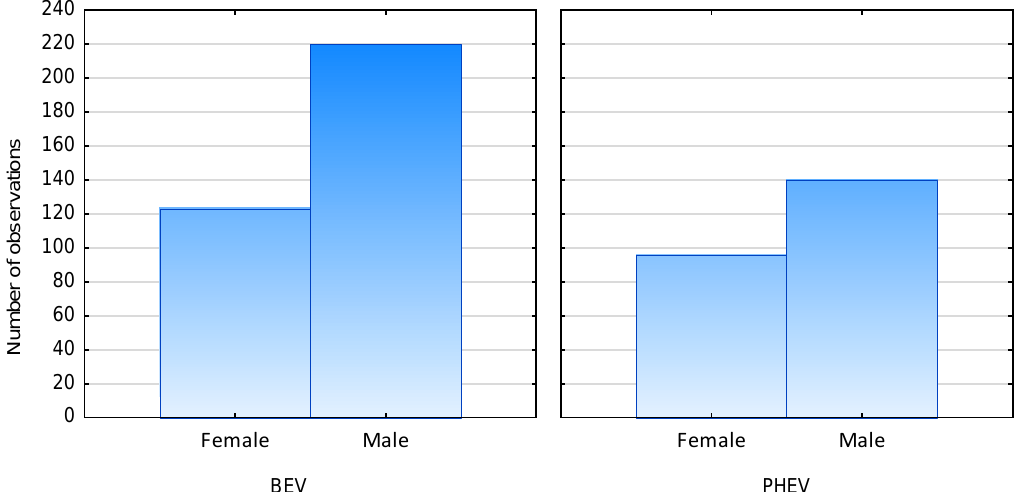
Figure 4. Categorized data histogram showing respondents’ opinions by gender in terms of BEV or PHEV vehicle type.